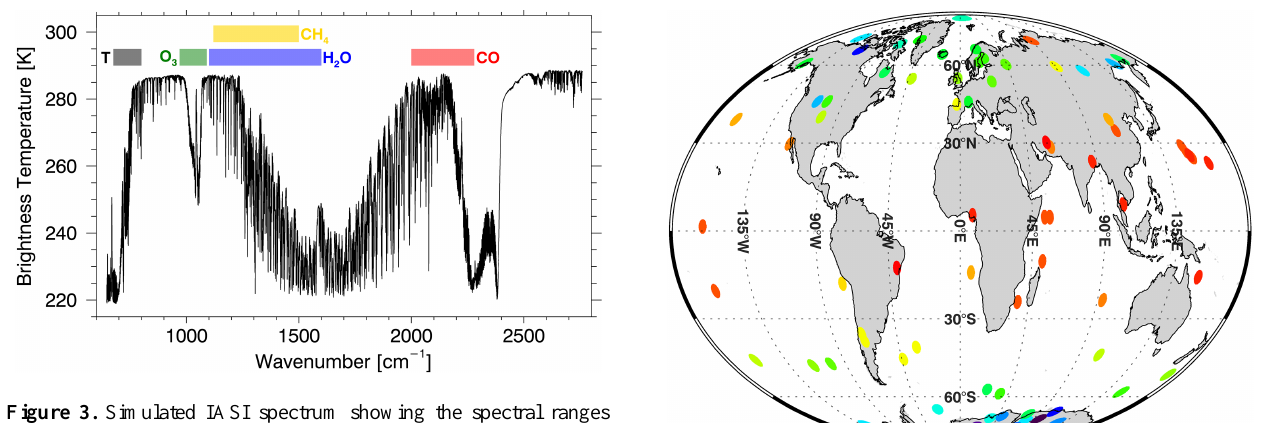
Figure 3. Simulated IASI spectrum showing the spectral ranges considered in this study, which are typical for temperature and trace gas profile retrievals with this instrument.